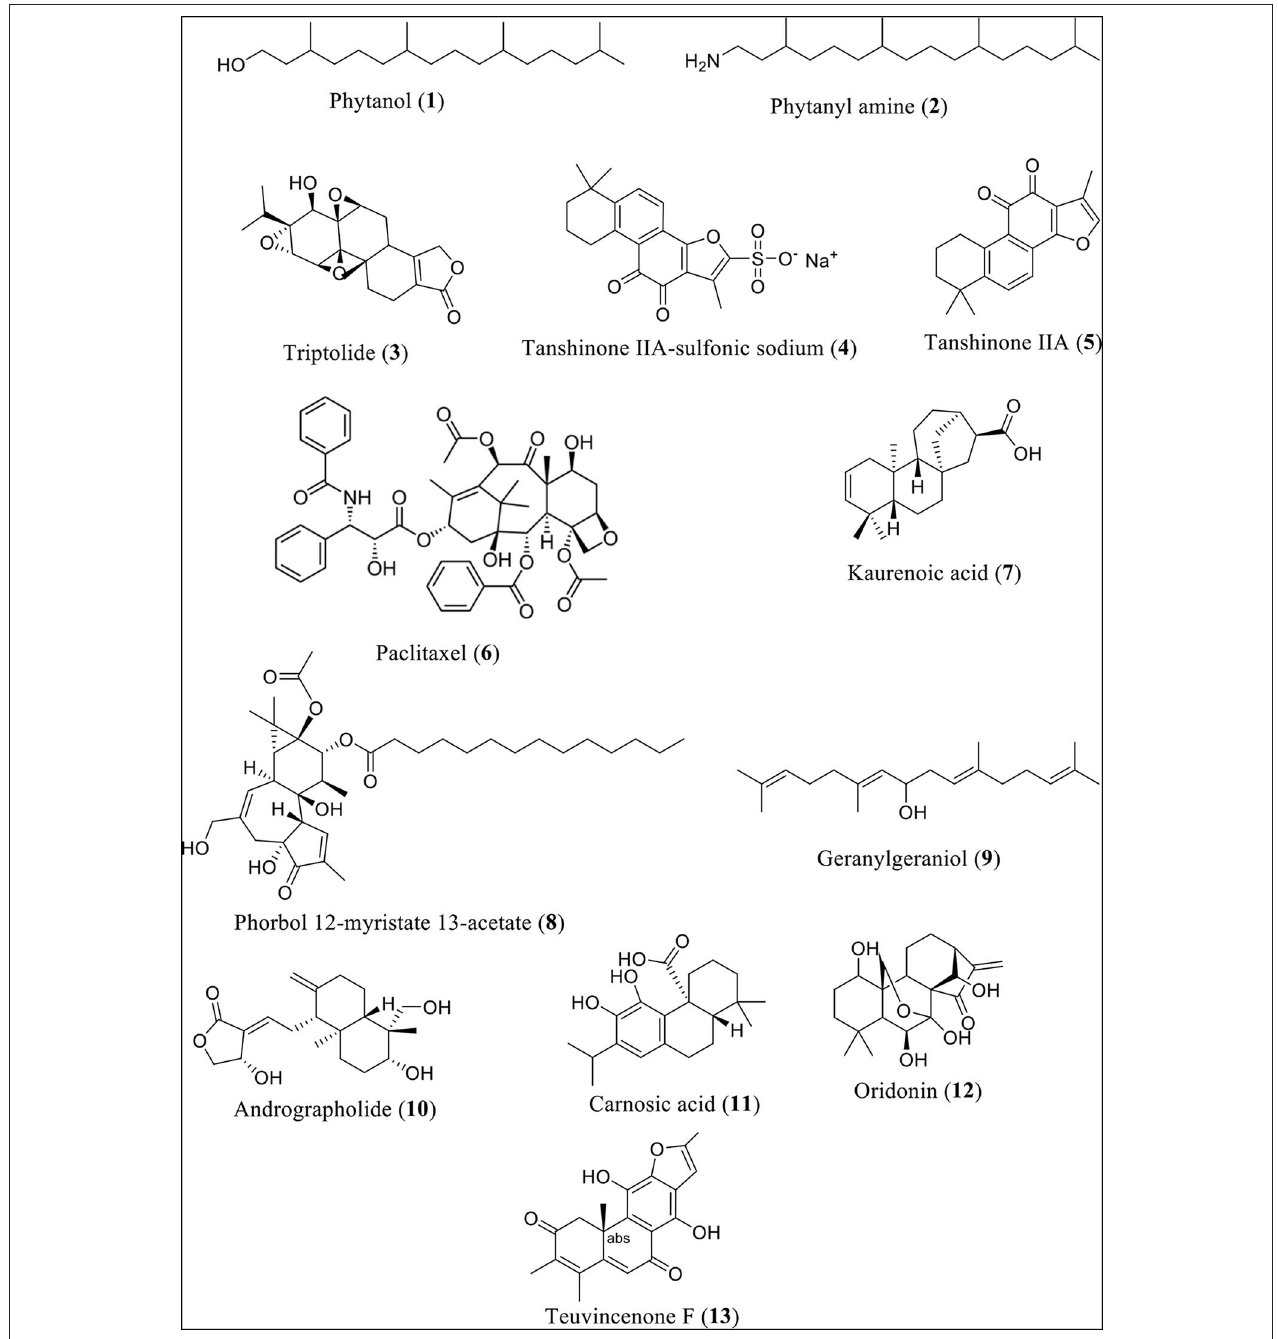
FIGURE 2 | Structures of some diterpenes or diterpenoids and their derivatives.